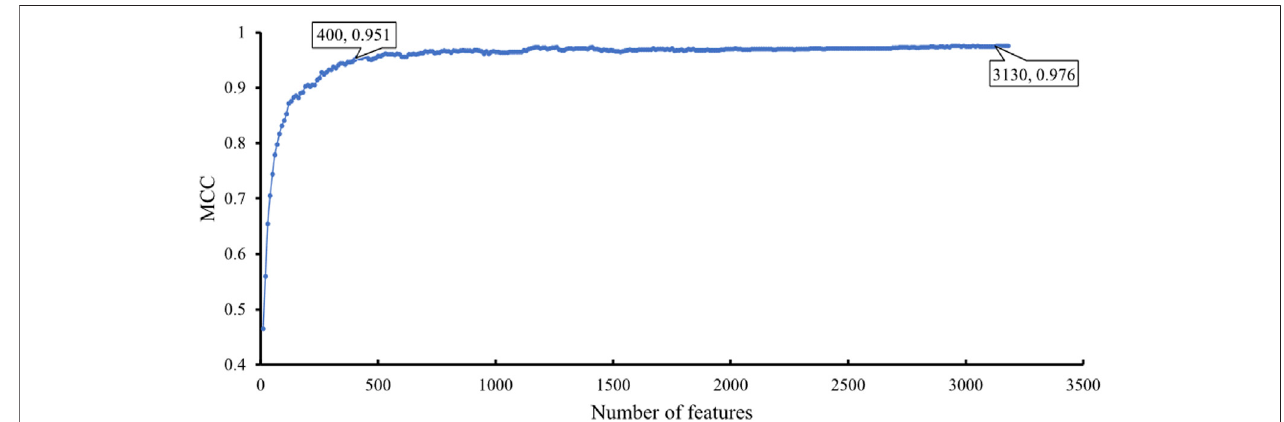
FIGURE 2 | IFS curve with SVM classi fi cation algorithm on the different number of features. The SVM provides the highest MCC of 0.976 when the top 3,130 features are adopted. When top 400 features are adopted, SVM provides good performance with MCC of 0.951.